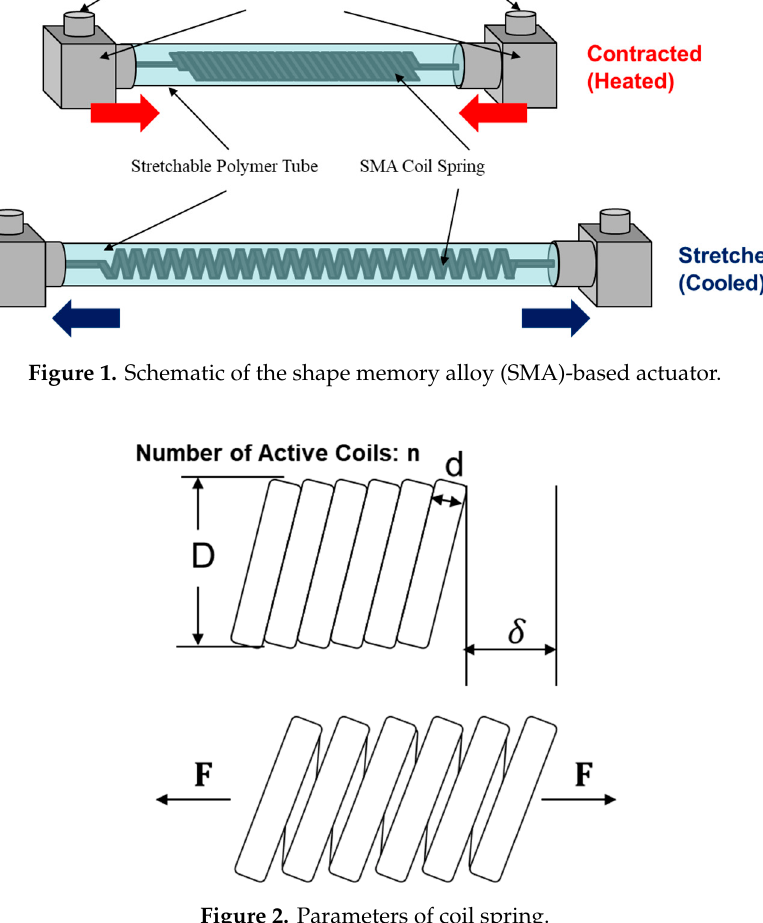
Table 1. Parameters of five shape memory alloy (SMA) coil spring